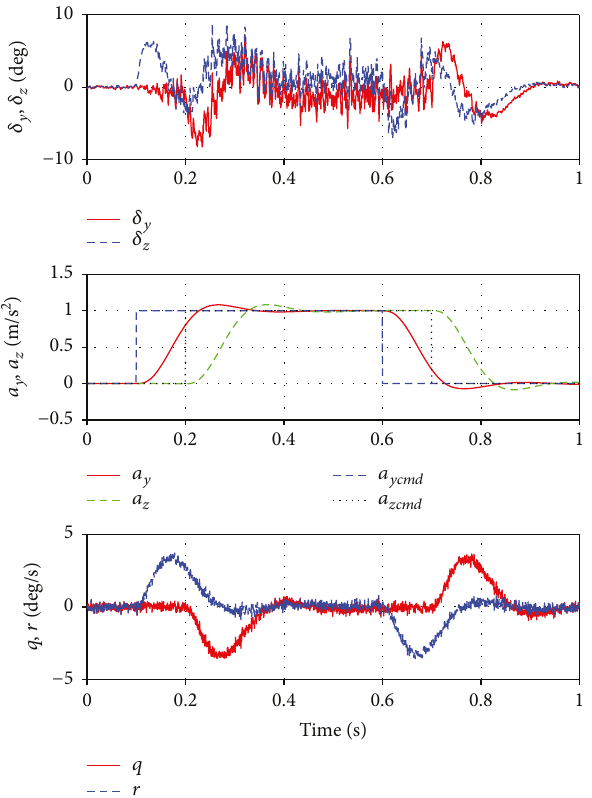
Figure 11: Adaptive controller performance with measurement